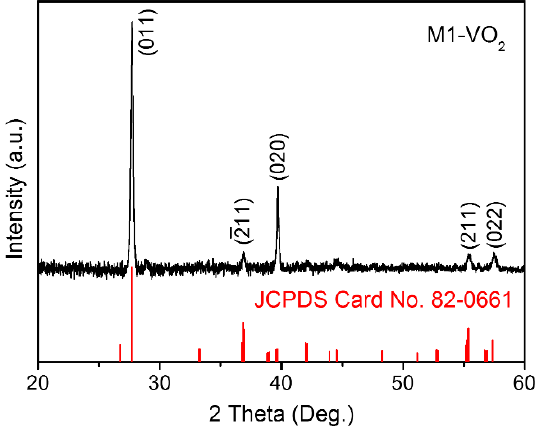
Figure 4. XRD pattern of VO 2 ceramic film grown on a single-crystal Si (100) substrate.